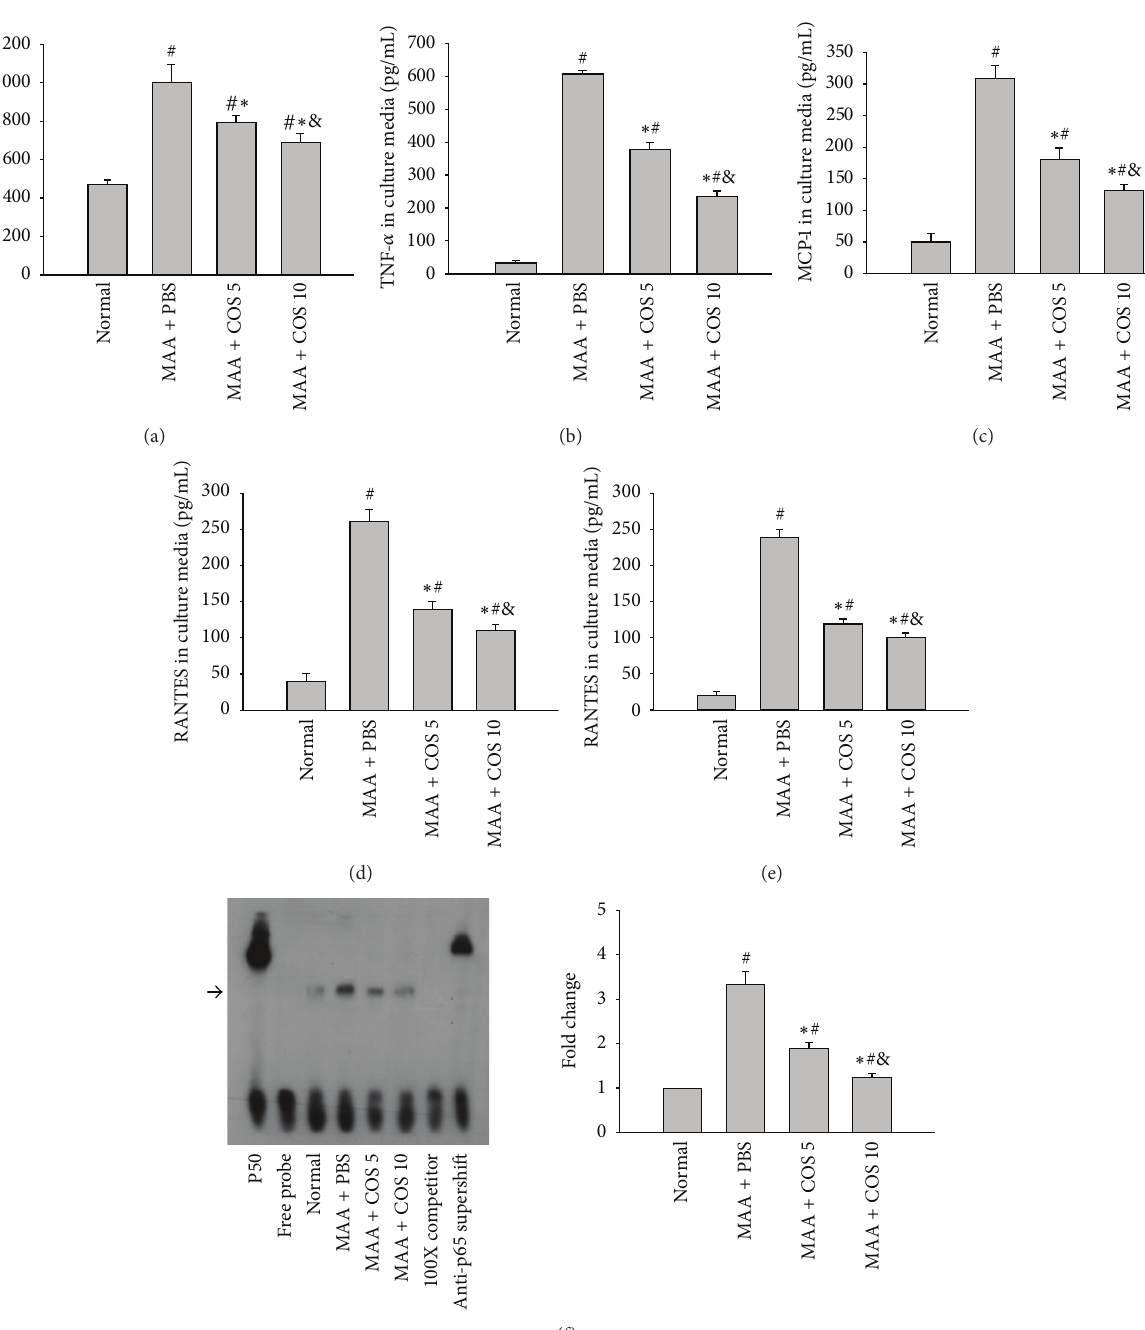
Figure 7: Effects of COS on spleen-derived lymphocyte chemotaxis, the secretion of inflammatory mediators, and the activation of NF- 𝜅 B. (a) Spleen-derived lymphocytes of each group were harvested and exposed to 10 𝜇 g/mL MAA for 3 days. These cells were placed in the upper chamber of a QCM apparatus, and the aqueous humor of the same group was placed in the lower chamber of the QCM apparatus. After 24 hrs of incubation, the migrated cells were stained with a green fluorescent dye and subjected to ELISA and the relative fluorescence unit was calculated.Theexpressionof(b)TNF- 𝛼 ,(c)MCP-1,(d)RANTES,and(e)fractalkineintheculturemediaofspleen-derivedlymphocytesfrom each group was measured using ELISA. (f) The NF- 𝜅 B/DNA binding activity of spleen-derived lymphocytes from each group was measured using EMSA. “Fold change” was defined as optic density of the PBS-treated, low-dose, or high-dose COS group divided by optic density of the normal group ( ∗ 𝑃 < 0.05 compared with the PBS-treated group; # 𝑃 < 0.05 compared with the normal group; & 𝑃 < 0.05 compared with the low-dose group by Kruskal-Wallis 𝐻 test with post hoc Dunn test; 𝑛 = 5 for each